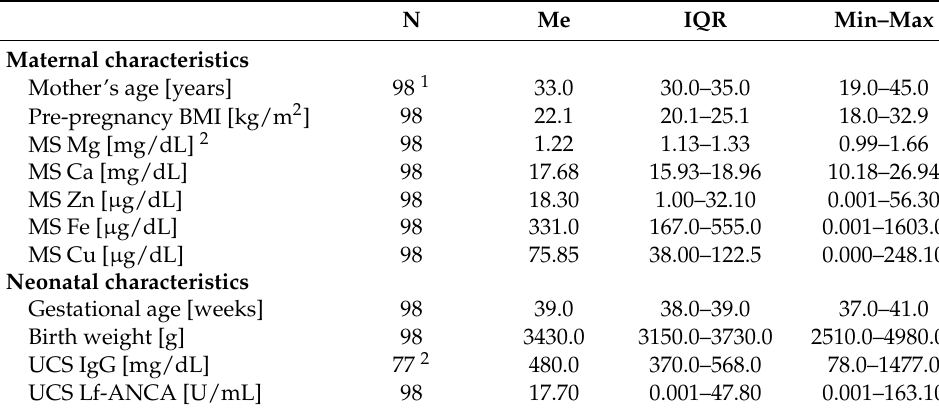
Table 1. Maternal and neonatal characteristics (N =